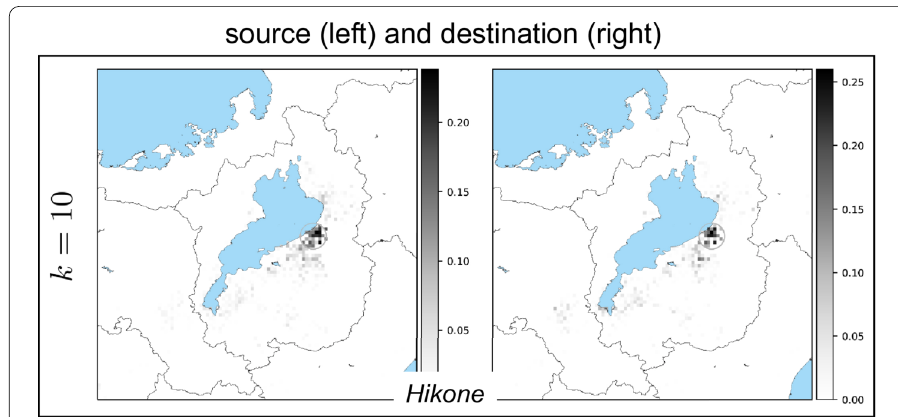
Figure 15 Cosine similarities between basis vectors. The vertical axis represents the indices of h k , i.e., the k th row vector of H , and the horizontal axis represents the indices of w k (cid:10) , i.e., the k (cid:10) th column vector of W . From top to bottom: k = 1, ... , K = 10; from left to right k (cid:10) = 1, ... , K = 10. Scale bar displays the magnitude of cosine similarities between h k and w k